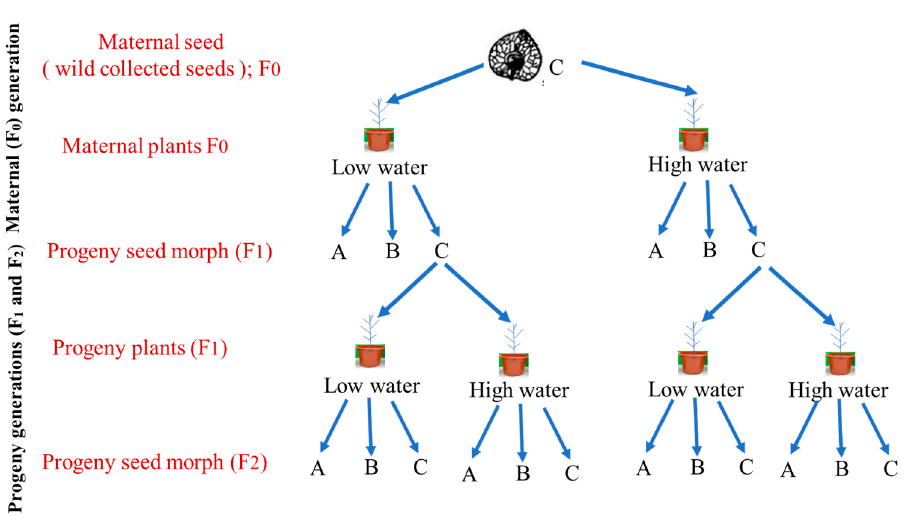
Figure 7. Experimental design for plants and seeds of maternal generation and progeny generations. A, B, and C indicate the seeds of type A, type B, and type C, respectively. Seeds (F 0 ) of A. aucher sowed in previous pot experiment were collected from a natural population growing in the hilly desert on the southern edge of Junggar Basin in Xinjiang in October 2010. Seeds were sorted according to seed types and only type C seeds were used in the previous pot experiment.